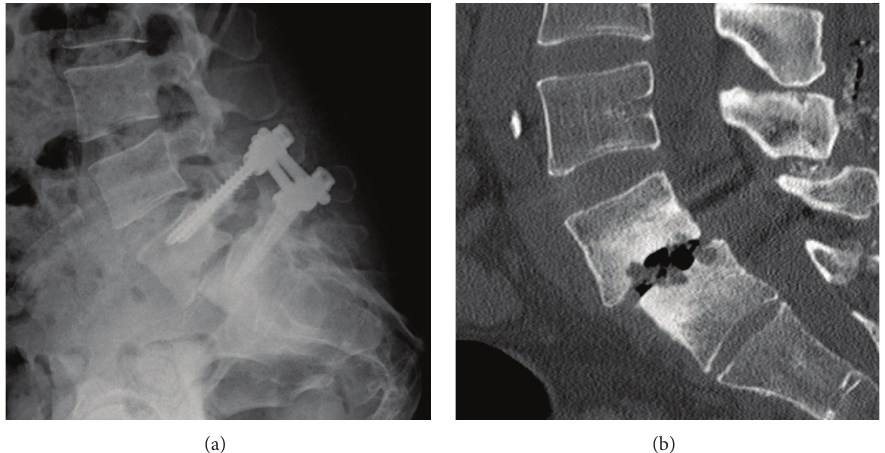
Figure 2: Lateral postop radiography (a) and postop CT scan (b) scan showed material in place, air in L5-S1 space, and reduction of the slippage